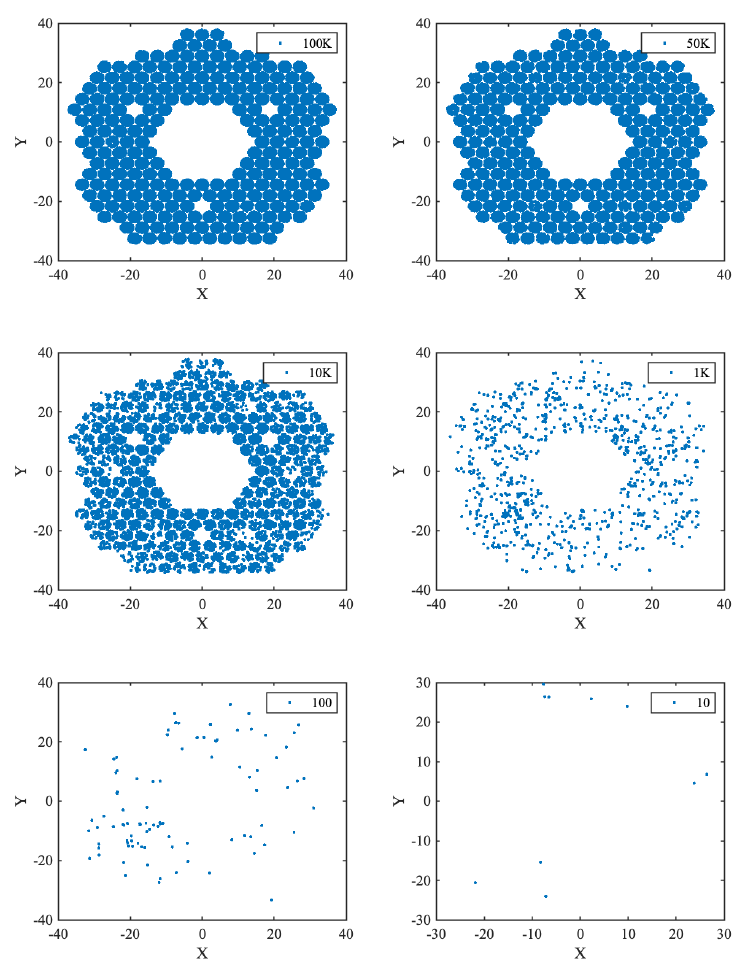
Figure 2. ACRR XY view of the coordinate